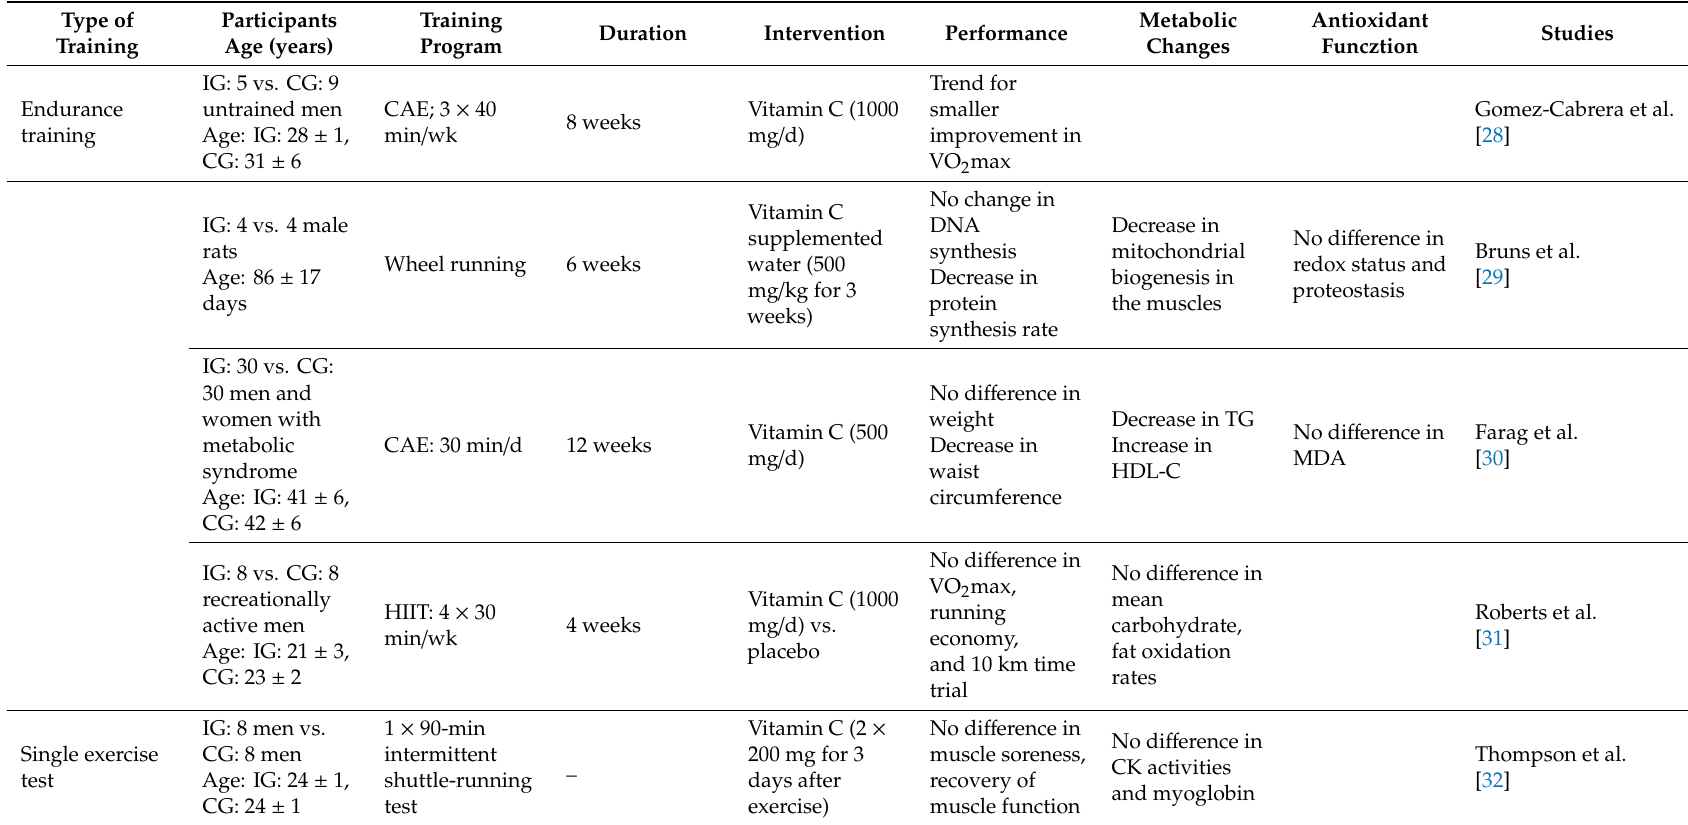
Table 1. Selected studies on the e ff ect of vitamin C administration to subjects performing physical